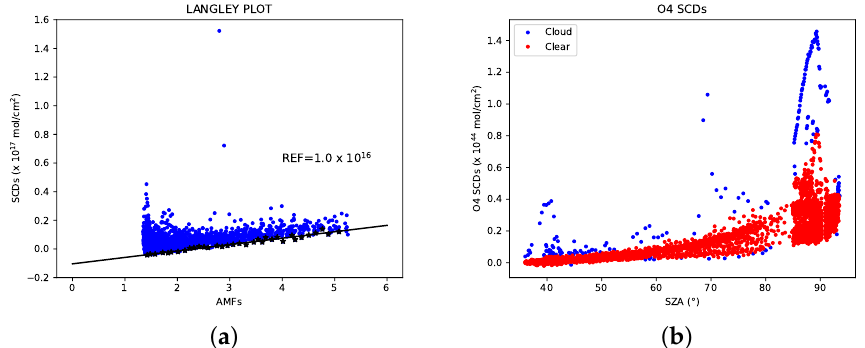
Figure 4. ( a ) Modified Langley plot and ( b ) O 4 SCDs data filtering for SkySpec-2D during the BAQUNIN inter-comparison campaign. Results for NO 2 cross sections at 254.5